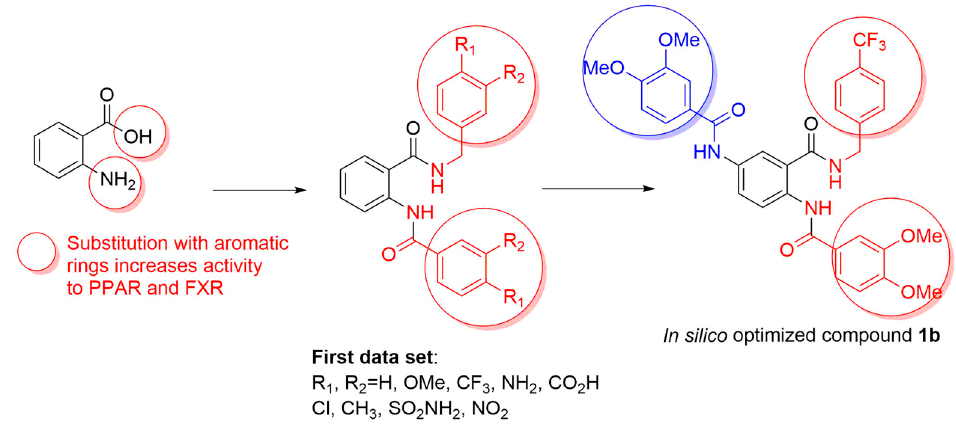
Figure 2. Docking based design of anthranilamides as multitarget drugs.